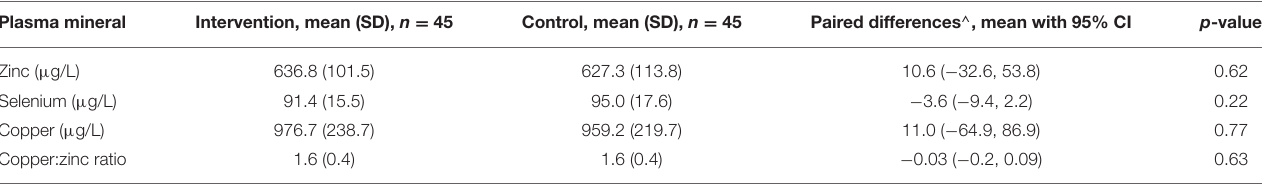
∧ Intervention minus control. P-values are obtained using Linear Mixed Model adjusted for